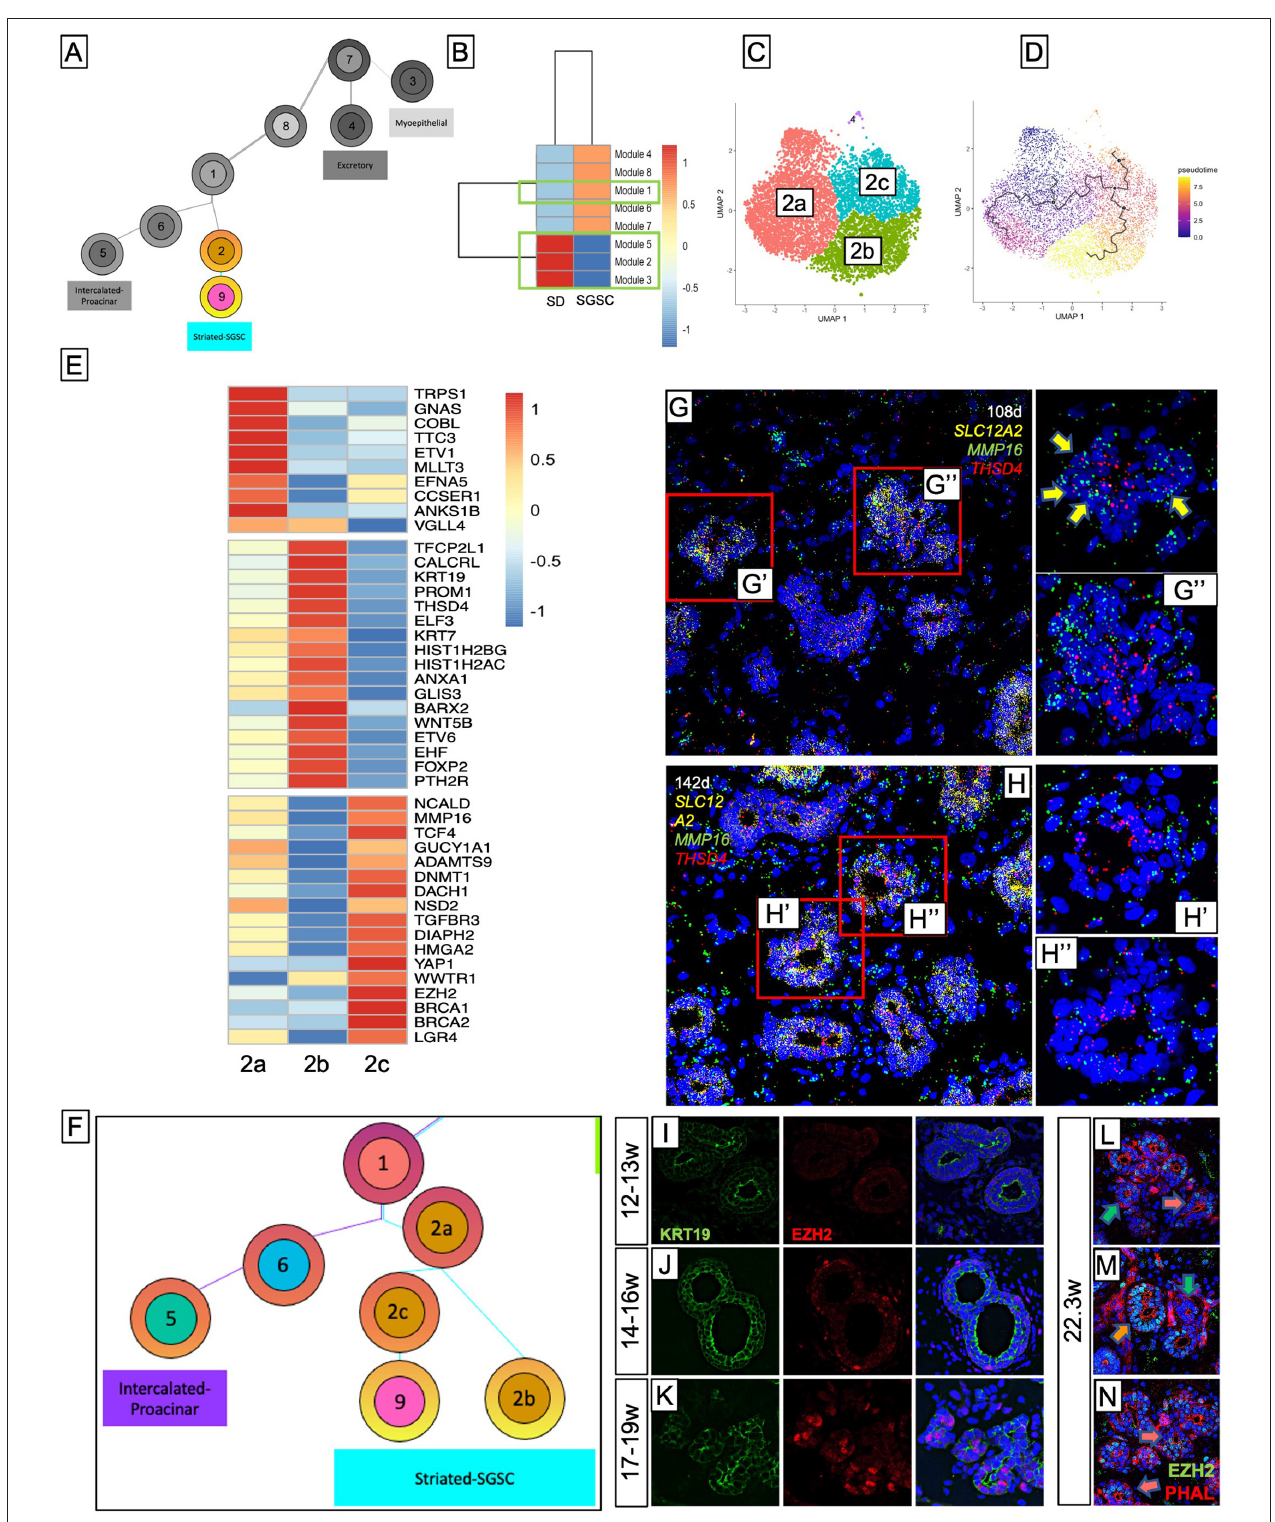
FIGURE 4 | Striated duct gives rise to a population of stem cell-like cells late in development. (A) SD gives rise to a subsequent cluster of stem cell-like cells. (B) Module analysis revealed that SD has three distinct modules of co-regulated genes. In conjunction with this, SD subsets into three distinct clusters (C) , where 2a gives rise to 2b and 2c. (D) Transcriptional analysis shows distinct transcriptional patterns for each cluster, with 2a showing transcriptional overlap with both 2b and